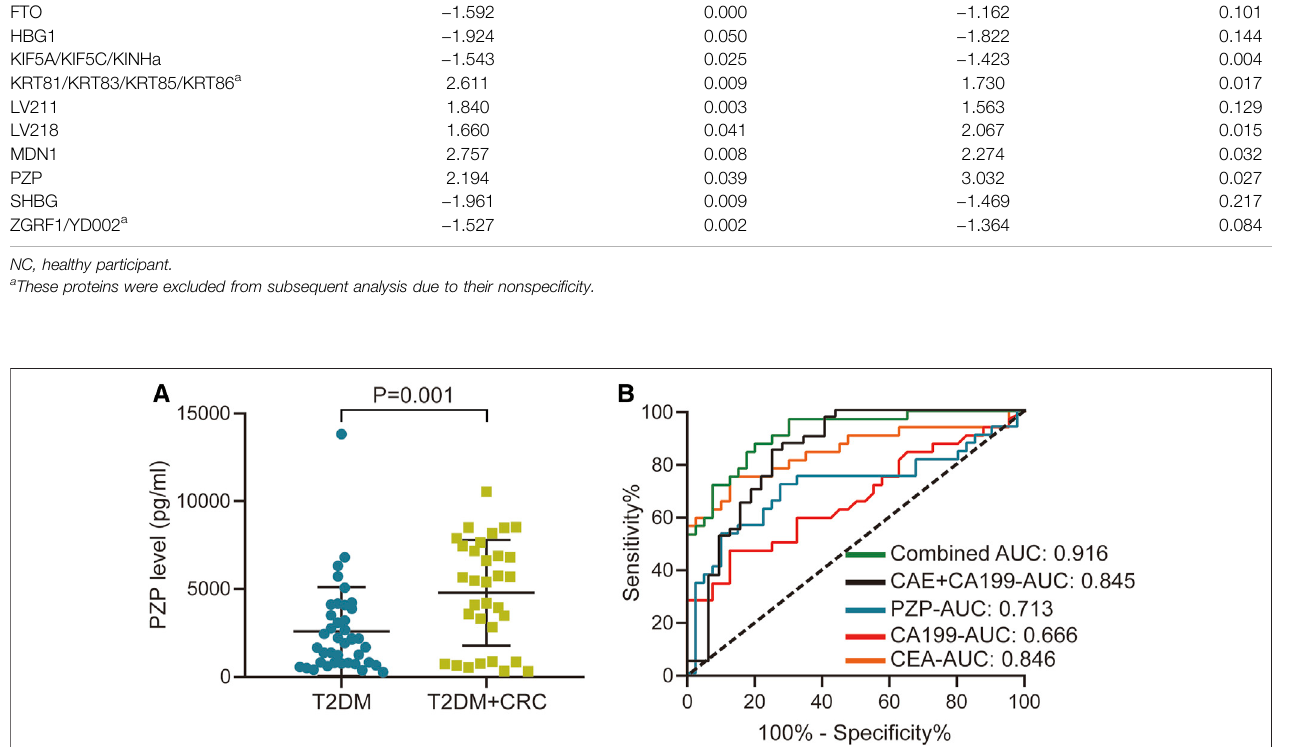
TABLE 2 | Unpaired t -test of the quantitative proteomic results for protein expression in the T2DM + CRC group in comparison with the control and T2DM groups. Proteins T2DM + CRC vs NC T2DM + CRC vs T2DM Fold change